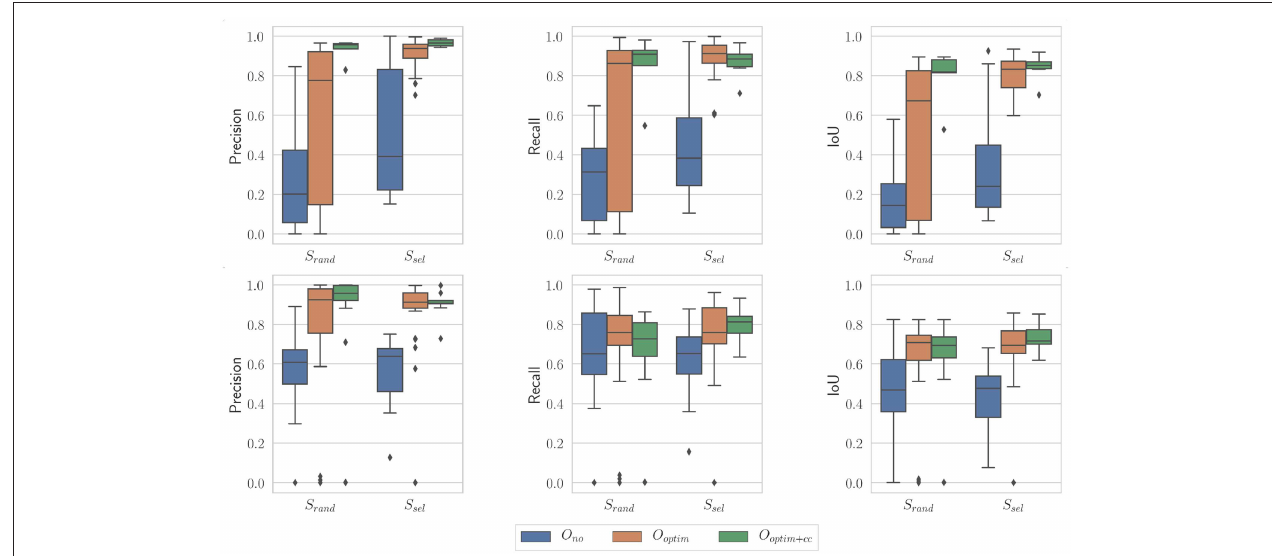
FIGURE 11 | Boxplots showing the evaluation metrics for N = 100 ; i = 10. (Top) In vivo dataset; (Bottom) Benchtop dataset.